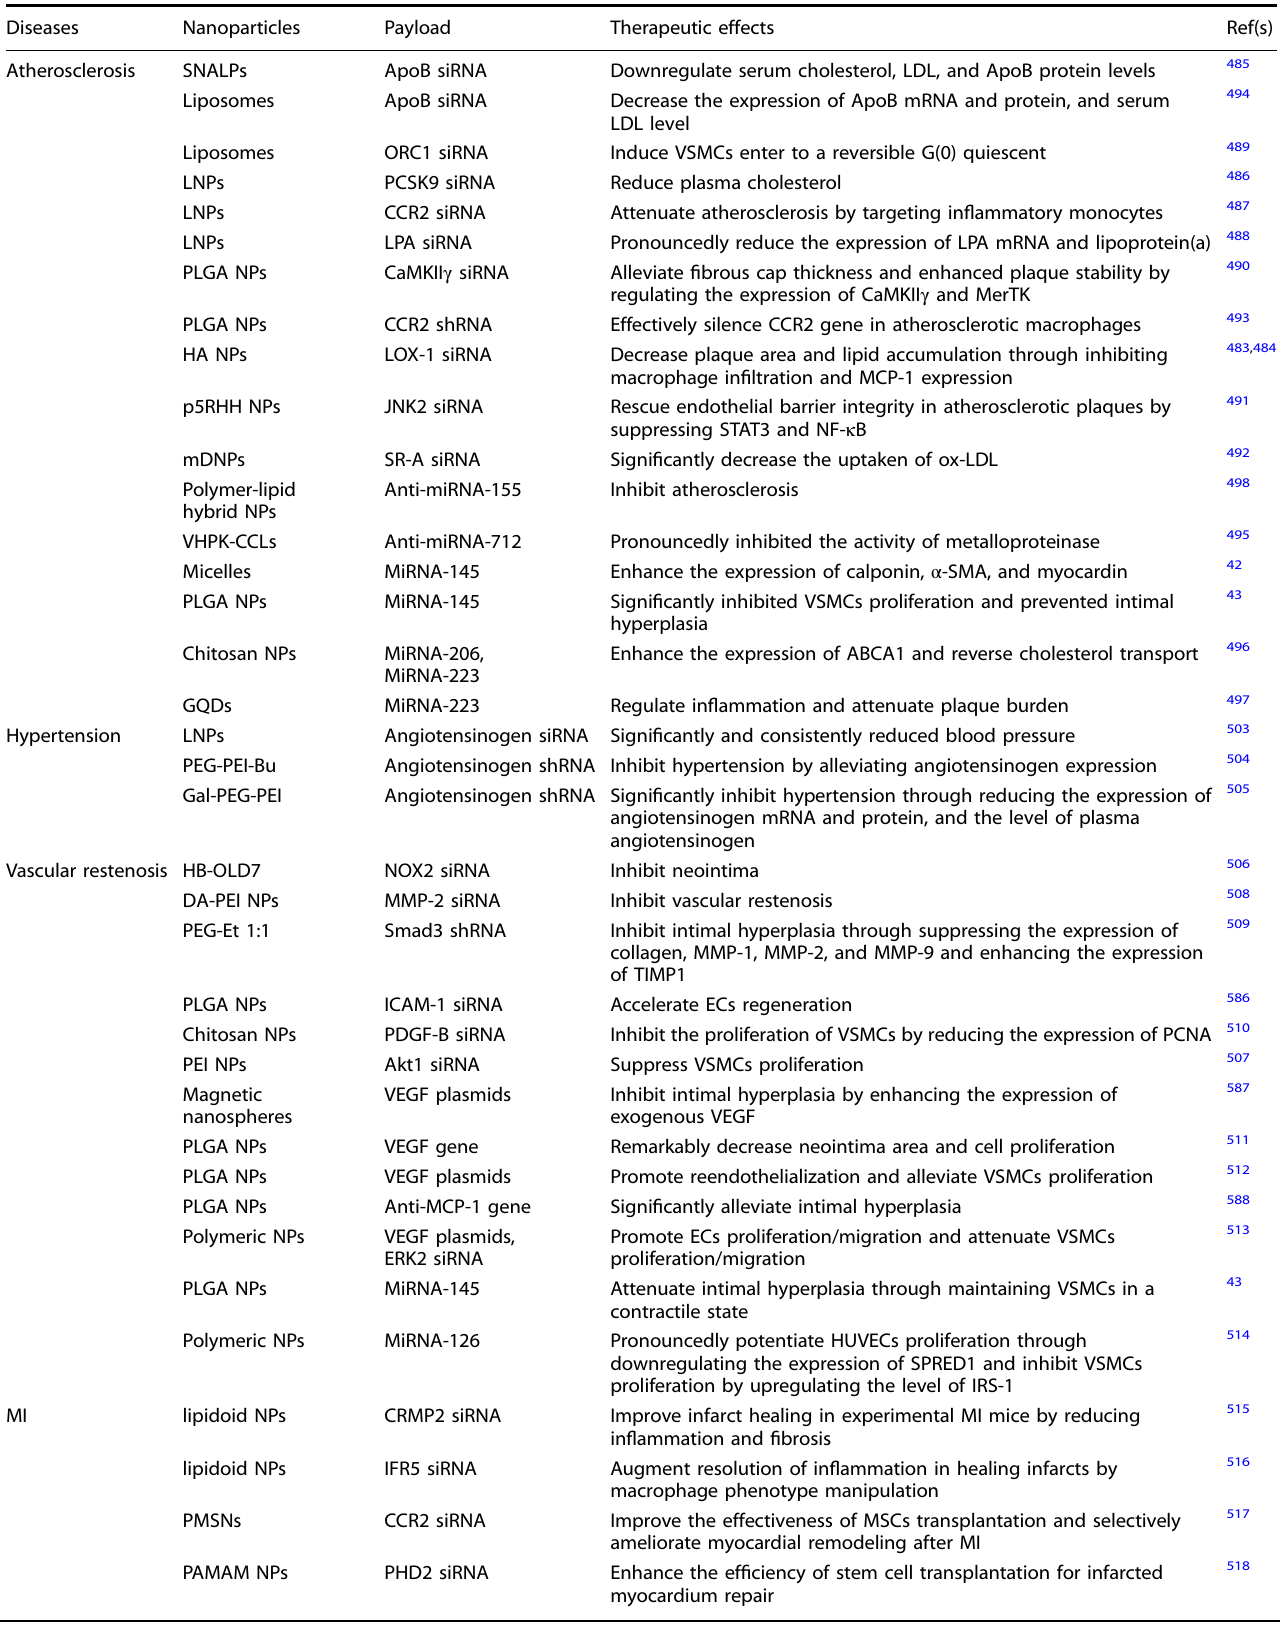
Table 5. Nanoparticle-mediated gene therapies for vascular aging-related diseases Diseases